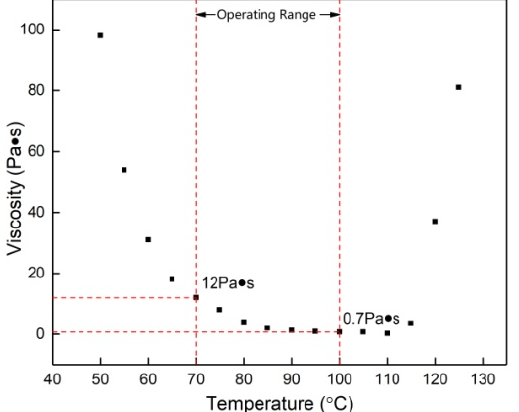
Figure 8. The viscosity-temperature curve of the rosin-sourced prepreg epoxy system.